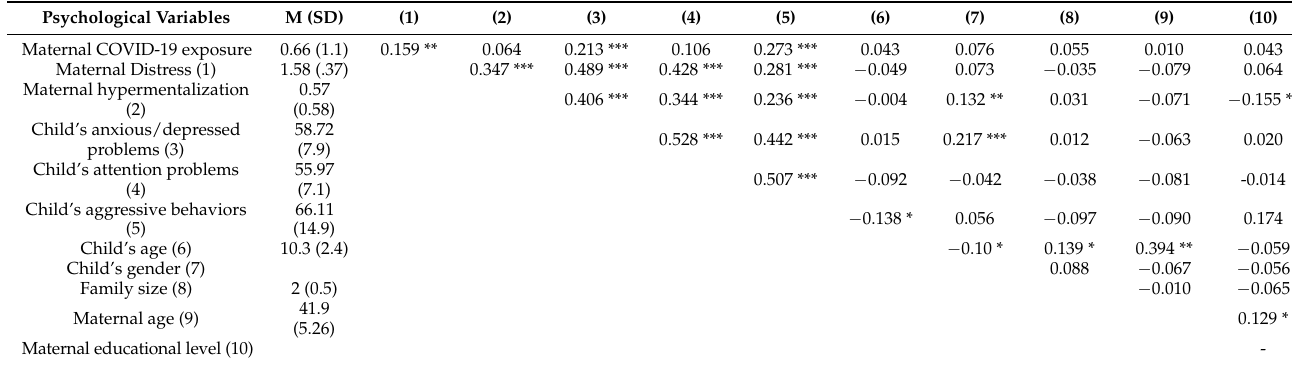
Table 1. Descriptives and correlation values between demographics features, maternal exposure to COVID-19, distress and reflective functioning, and children’s outcomes.